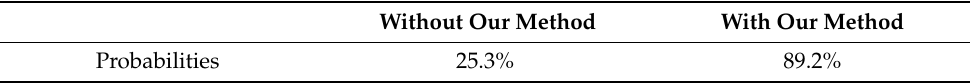
Table 4. Probabilities of synchronization with and without our